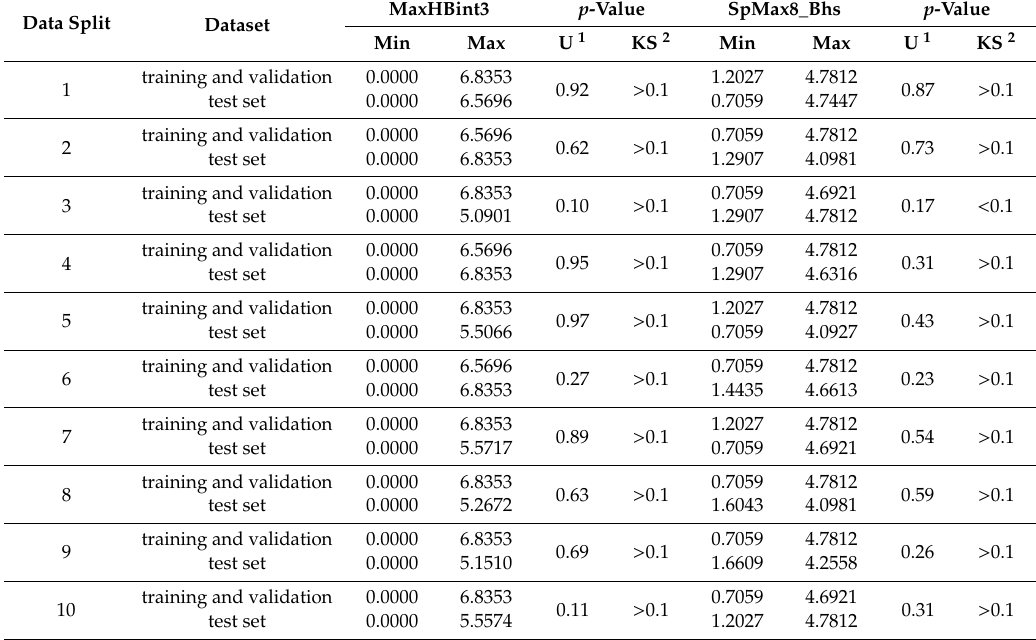
Table 4. The analysis maxHBint3 and SpMax8_Bhs descriptor ranges and